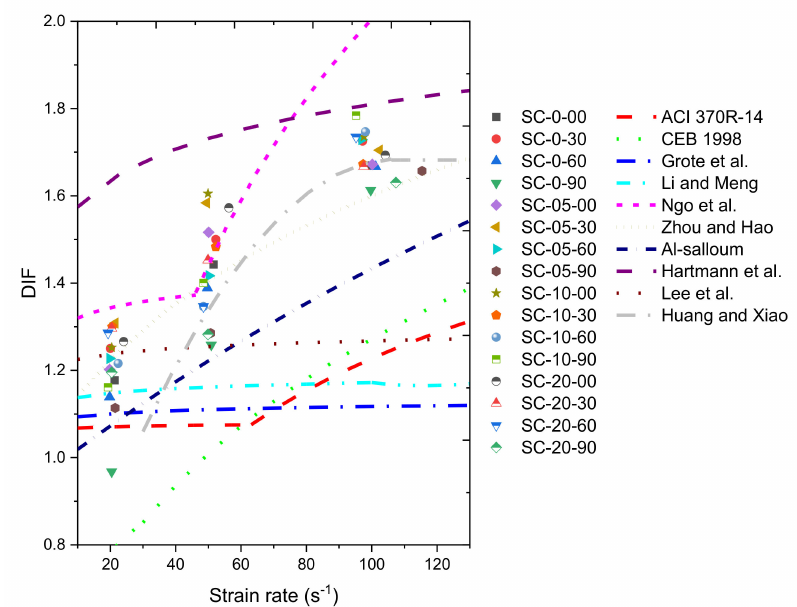
Figure 6. Experimental data in the present study and equations in the